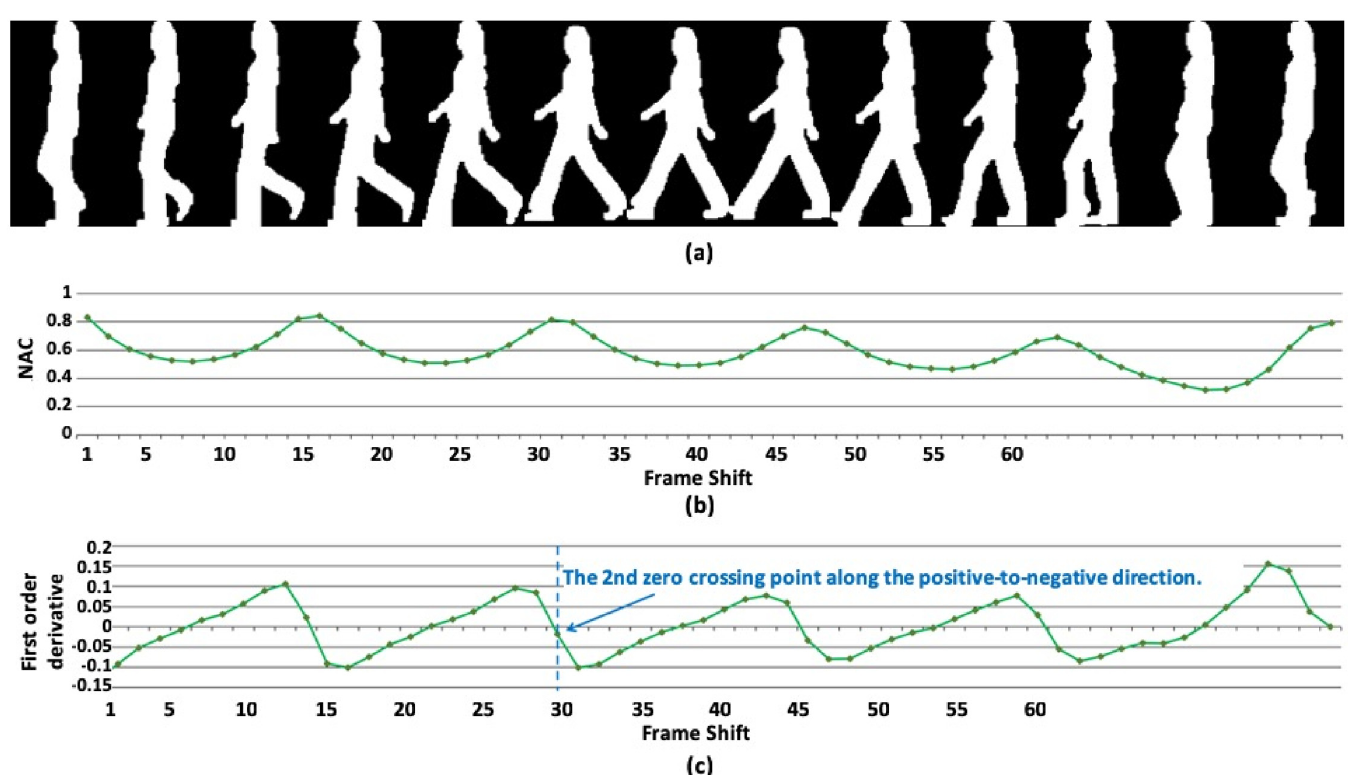
Fig 3. Gait period analysis: (a) The gait silhouettes for the extracted figure-centric images of a walking person; (b) The estimated NACs; and (c) The first-order derivative curve of NACs.